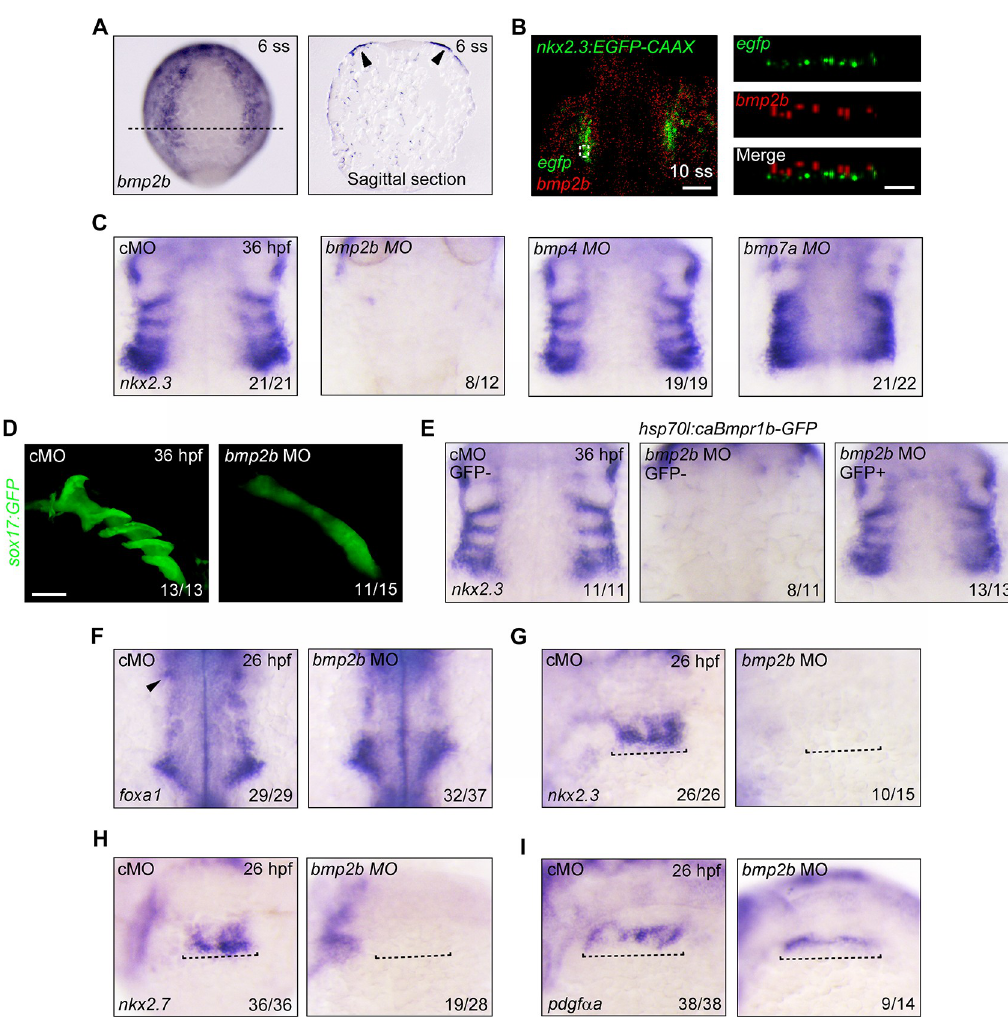
shown in the right panel. The black dotted line indicates the plane of the section. ( B ) Whole-mount RNAscope assays showing expression of egfp in lateral pharyngeal endoderm (green) and bmp2b in pharyngeal ectoderm (red) of Tg(nkx2 . 3 : EGFP-CAAX) transgenic embryos at the 10-somite stage. Left panel shows the merged sections in X-Y view (Scale bar, 50 μ m); the right panel shows higher magnification orthogonal section of the boxed area in the left panel (Y-Z view; Scale bar, 10 μ m). ( C ) In situ hybridization of nkx2 . 3 at 36 hpf in wild-type embryos injected with 4 ng cMO, 0.25 ng bmp2b MO, 2 ng bmp4 MO, and 4 ng bmp7a MO, respectively. Note that the expression of the pouch marker nkx2 . 3 was not notably disrupted in bmp4 MO or bmp7a MO-injected embryos, but was depleted in bmp2b morphants. ( D ) Malformed lateral pharyngeal endoderm (green) in 0.25